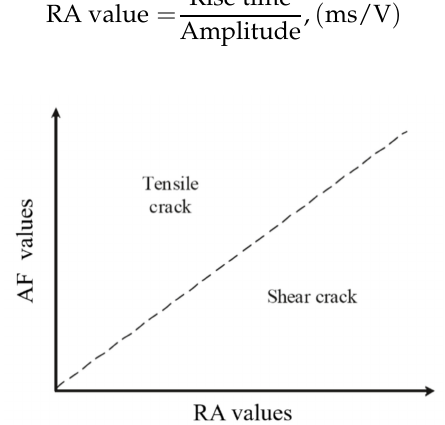
Figure 2. Failures were classified according to average frequency (AF) and RA